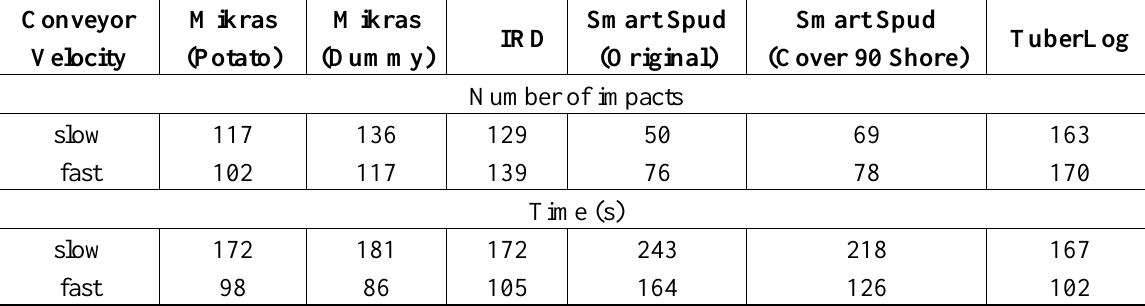
Table 3. Number of impacts and time duration detected during 10 runs through the processing line simulator without chute (threshold value for peak acceleration 30